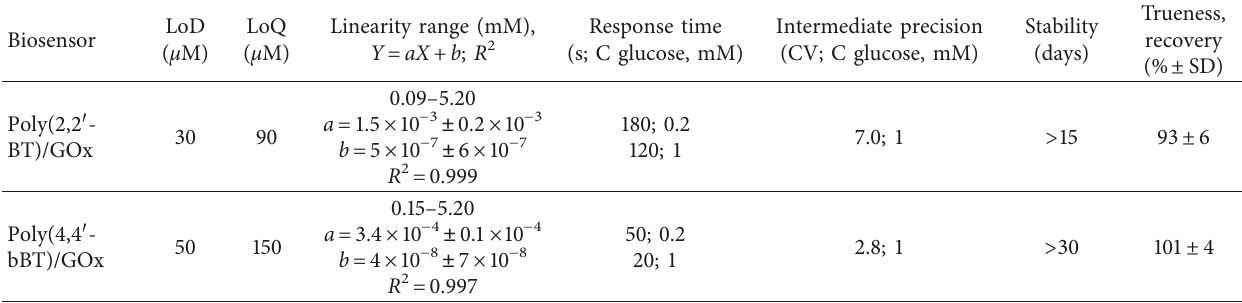
Table 1: Selected validation data for the determination of glucose with (a) poly(2,2 ′ -BT)/GOx and (b) poly(4,4 ′ -bBT)/GOx-based